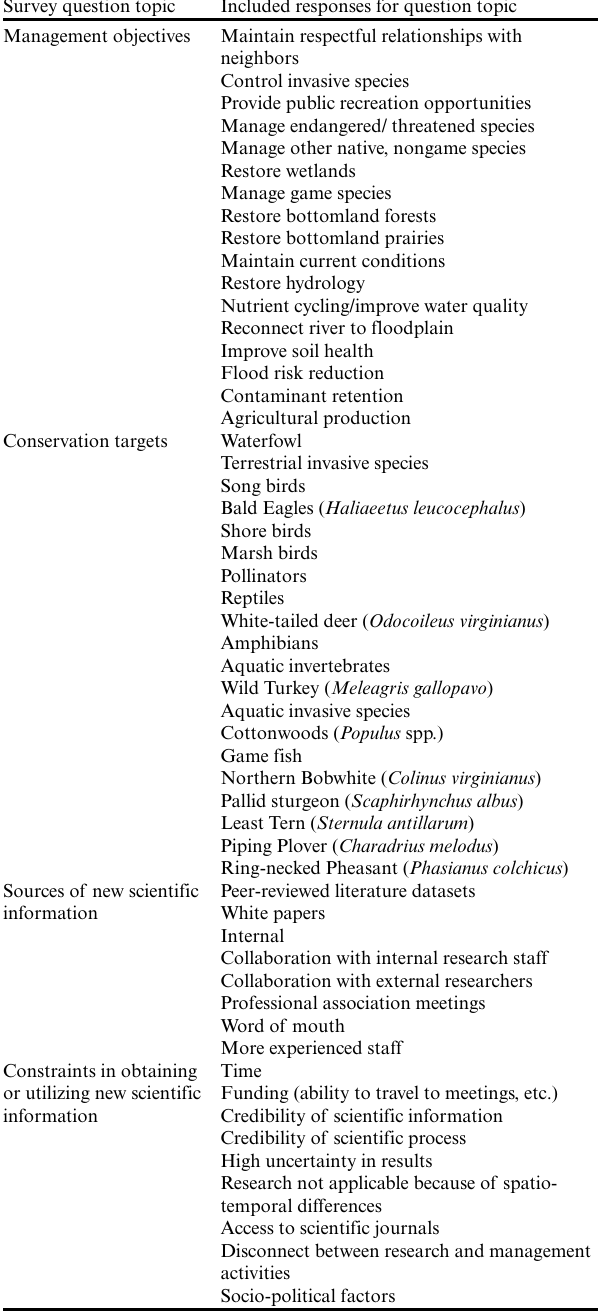
Table 2 . Lists of selected management objectives, conservation targets, information sources, and constraints in floodplain management included in the first survey to 80 floodplain managers in the Lower Missouri and Upper and Middle Mississippi